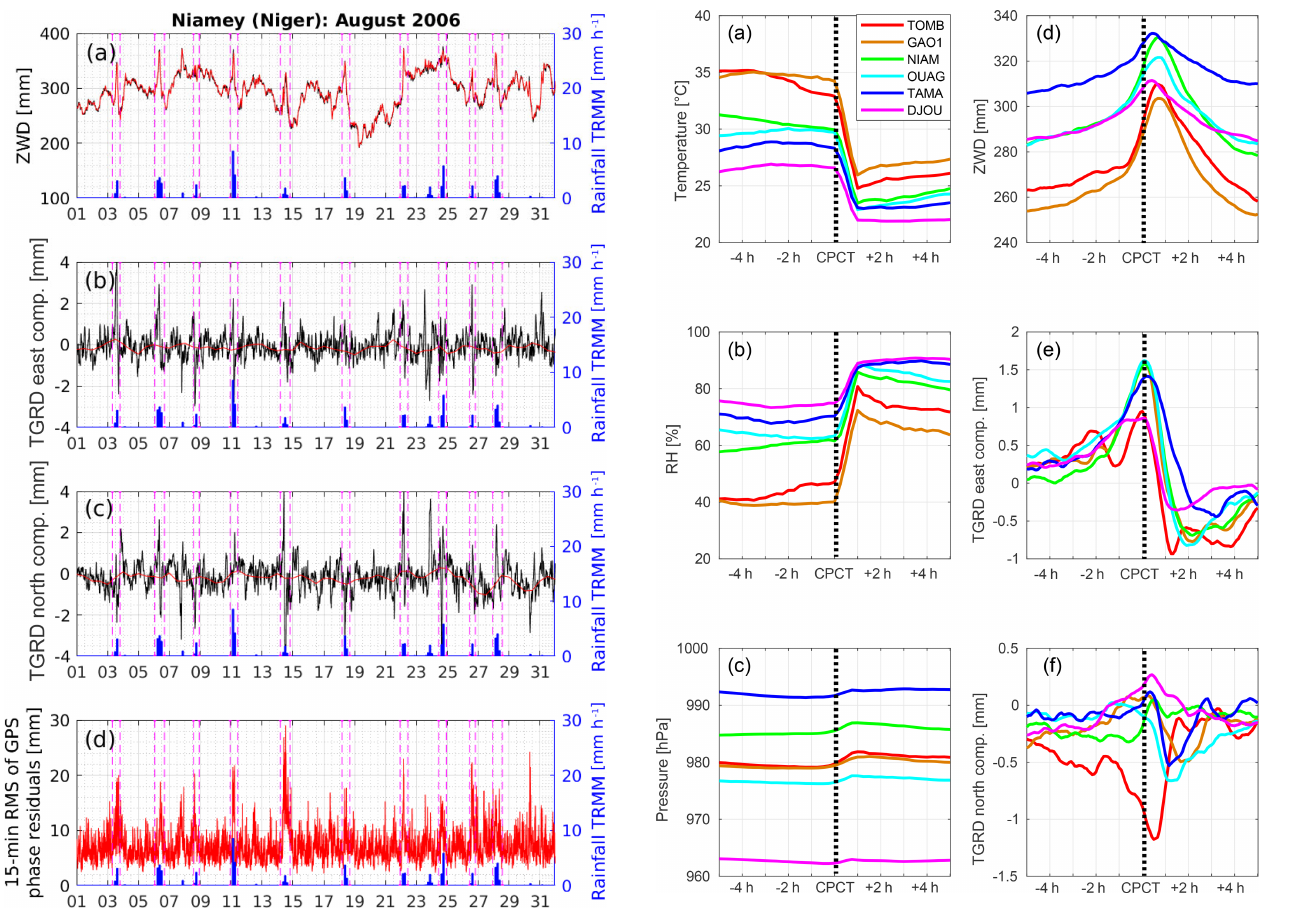
Figure 12. Tropospheric estimates from GIPSY-OASIS (black) and GAMIT (red) at Niamey during August 2006: (a) zenithal wet delay (mm), (b) east and (c) north components of tropospheric gradients (mm), and (d) the 15min RMS of GPS phase residuals (mm). Each MCS detected is shown using two dashed vertical magenta lines indicating the start and end of the rainfall period.